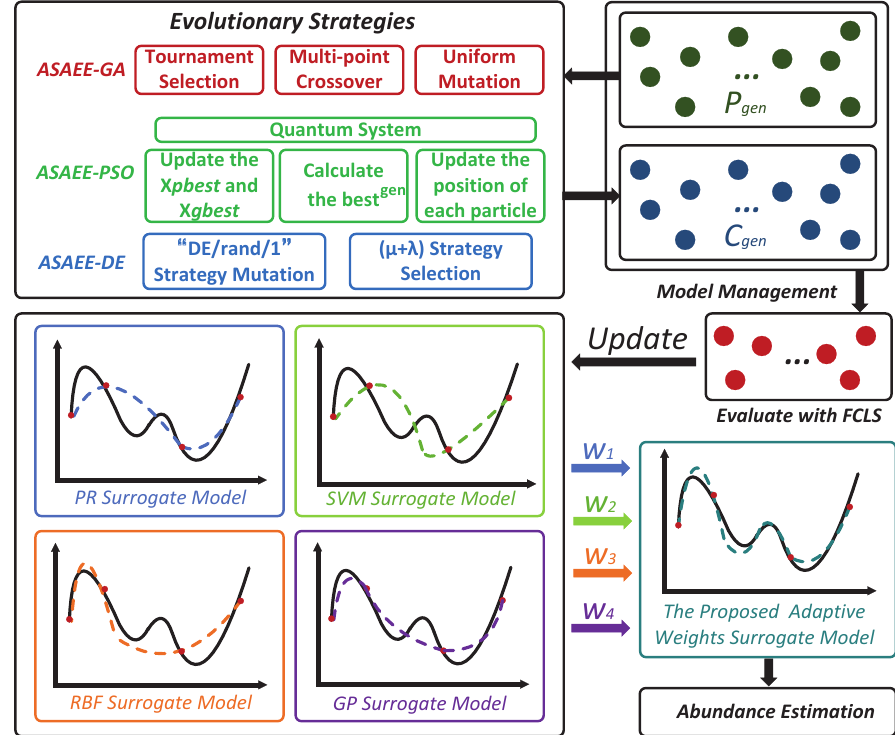
Figure 2. Illustration of the proposed ASAEE